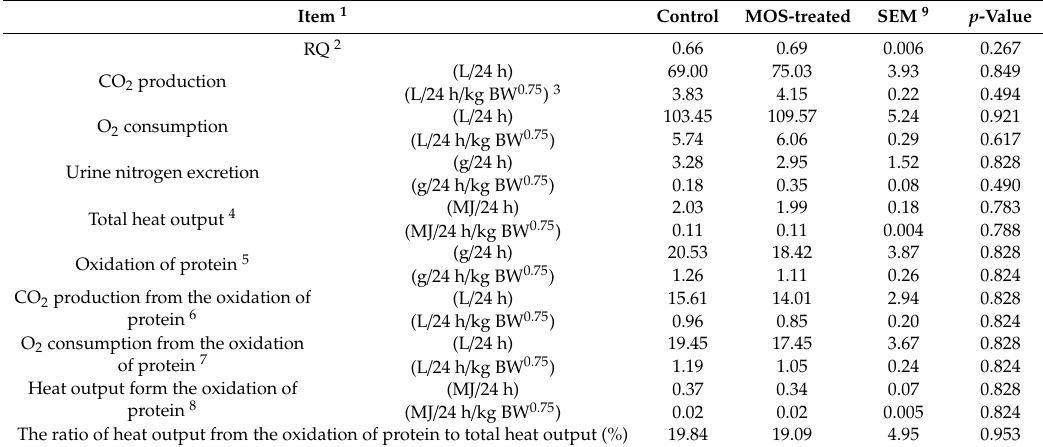
Table 5. In vivo gas production and energy metabolism of control and MOS-treated sheep under fasting metabolism